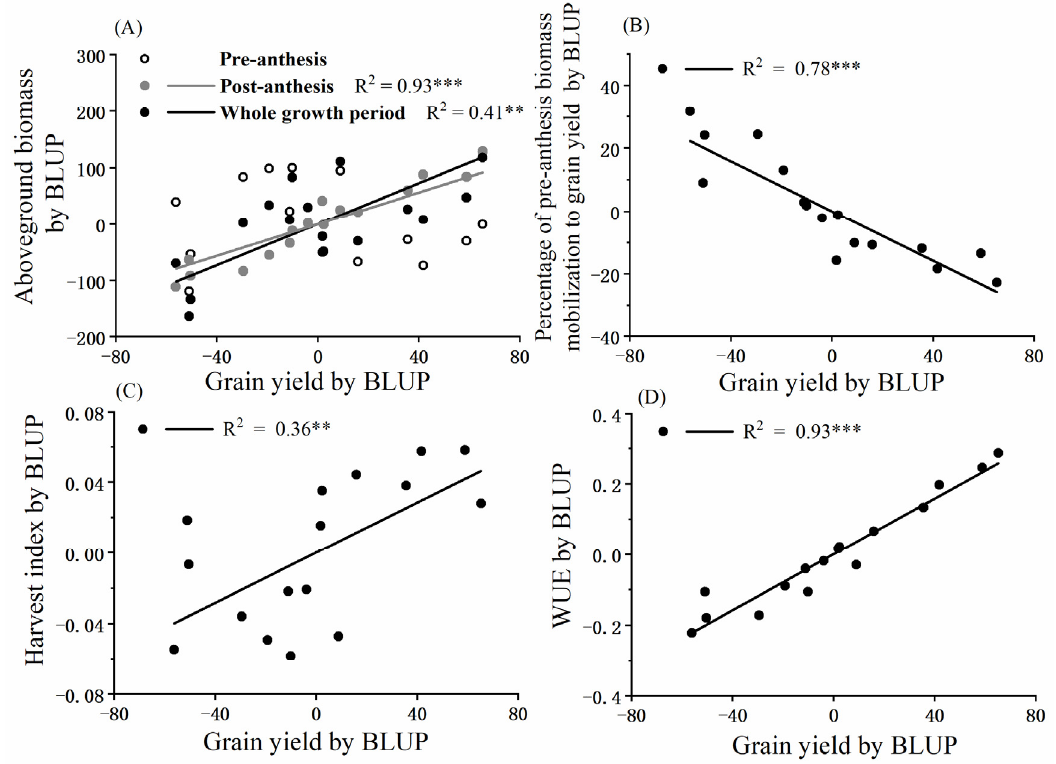
Figure 6. The relationship between grain yield by BLUP and ( A ) accumulation of aboveground biomass in the pre-anthesis, post-anthesis, and at maturity by BLUP; ( B ) percentage of pre-anthesis biomass mobilized to grain yield by BLUP; ( C ) harvest index by BLUP; and ( D ) water use efficiency (WUE) by BLUP. Only the significant linear regressions are shown. ** p < 0.01; *** p < 0.001 .